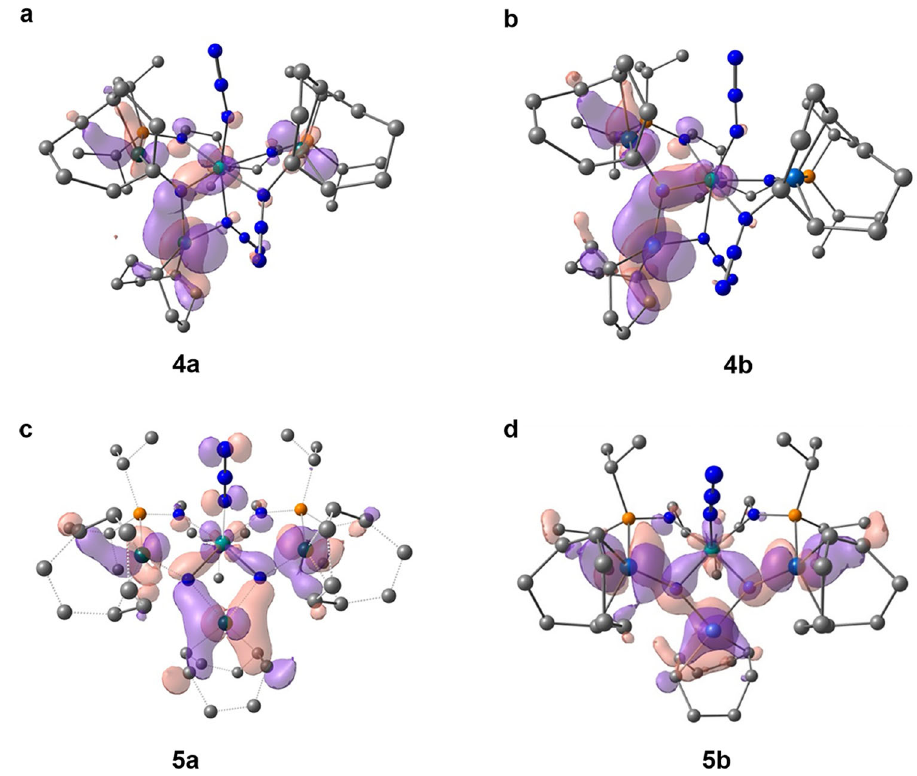
Fig. 6 Molecular orbitals. U-N-Rh(Ir) bonding molecular orbitals of complexes 4a ( a ), 4b ( b ), 5a ( c ) and 5b ( d